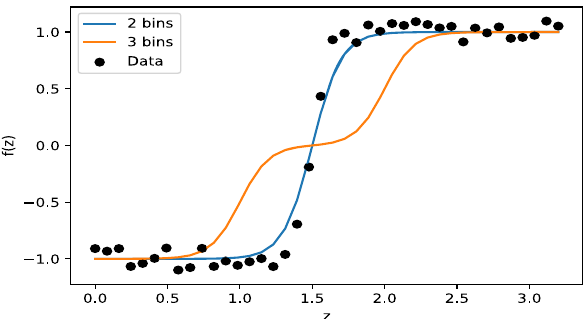
Fig. 8 Visual representation of the possibility of underfitting data with more parameters